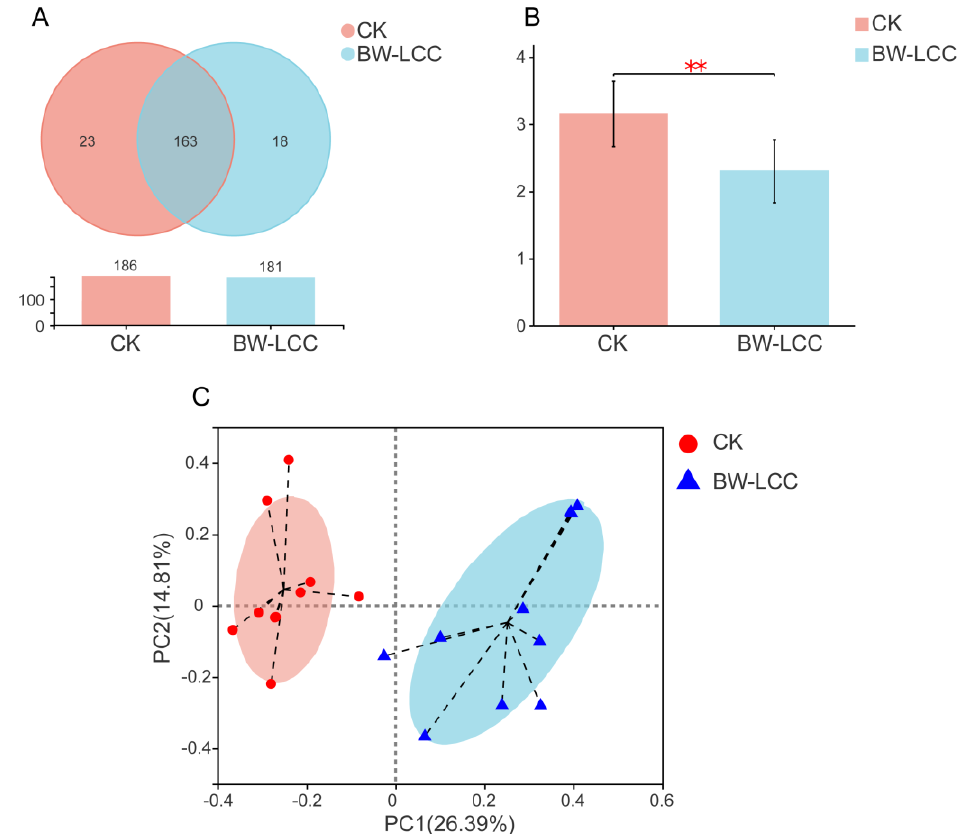
Figure 3. Diversity index of the intestinal microbial community after fermentation. ( A ) Venn diagram analysis at the OTU level. ( B ) The Shannon diversity index of microbial communities under each treatment at 24 h. Significance was determined between BW-LCC and CK using Wilcoxon rank-sum test; **, p < 0.01. ( C ) Principal Component Analysis (PCoA) based on diversity at the OTU level between the CK and BW-LCC groups.